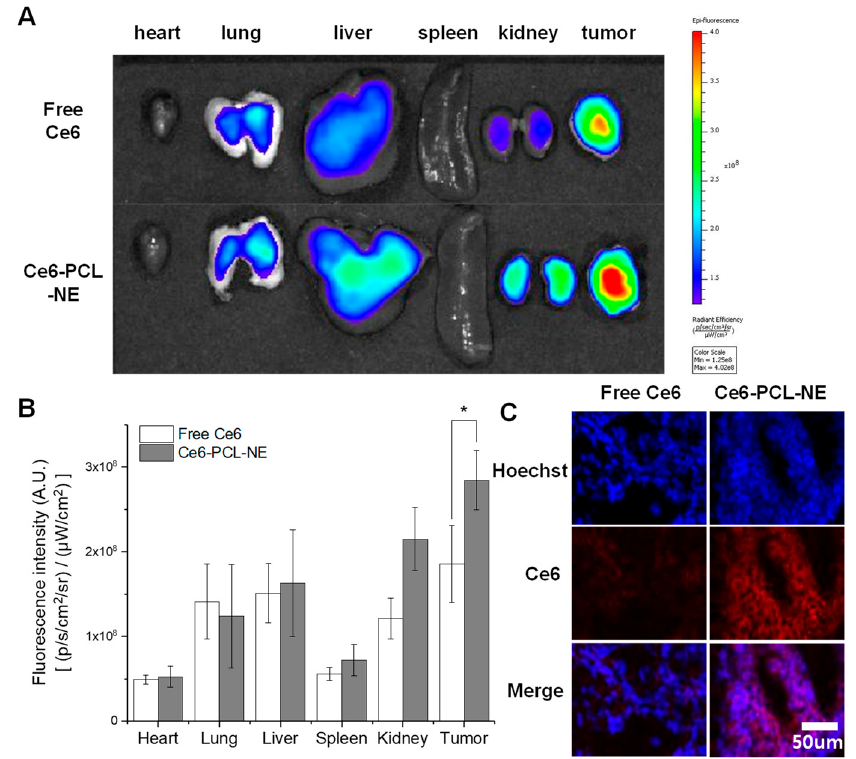
Figure 5. Ex vivo imaging analysis of Ce6-PCL-NE in 4T1 tumor-bearing mice. ( A ) Ex vivo fluorescence images of the dissected tumors and major organs (heart, lung, liver, spleen, and kidney) 12 h post-injection of free Ce6 and Ce6-PCL-NE into 4T1 tumor-bearing mice. ( B ) Quantification of fluorescence intensity of ( A ) ( n = 3). * p < 0.05. ( C ) Fluorescence images of the sliced tumor tissue 12 h after injection of free Ce6 and Ce6-PCL-NE.